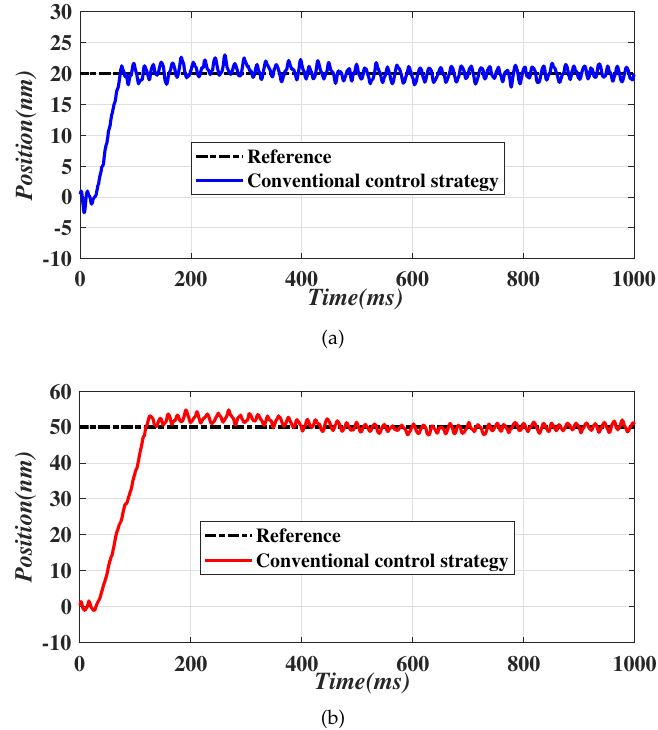
Figure 7. Tracking curve for reference displacement. ( a ) Reference = 20 nm. ( b ) Reference = 50 nm.